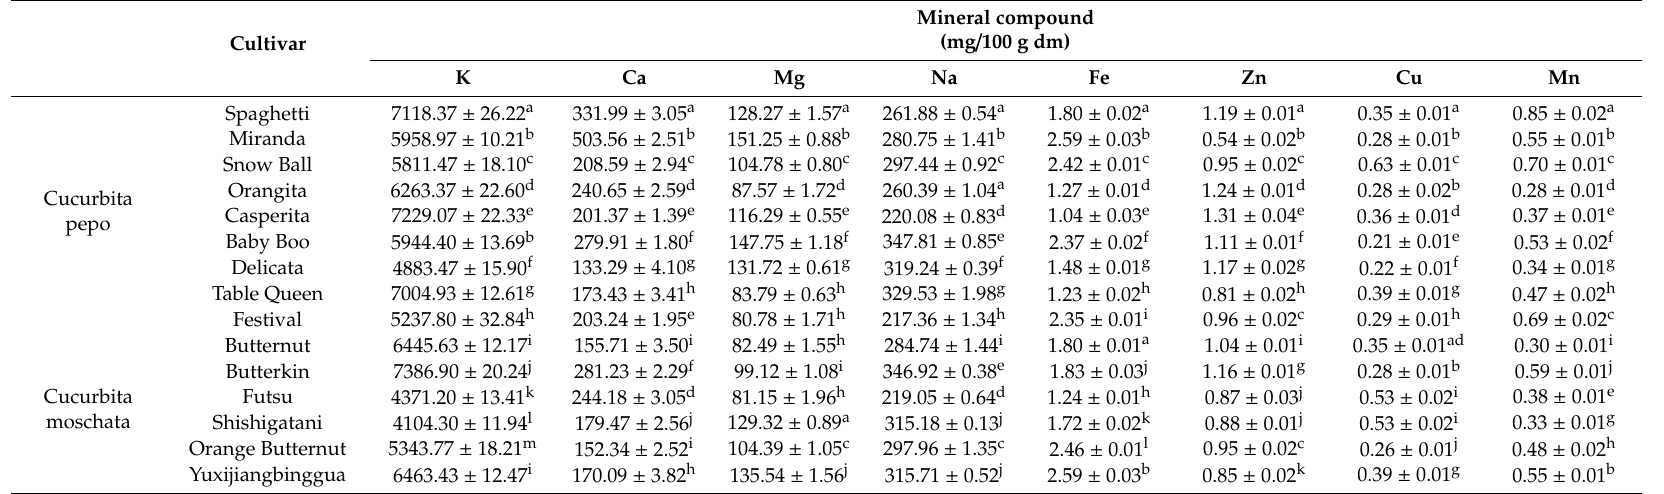
Table 5. The content of mineral compounds in pumpkin